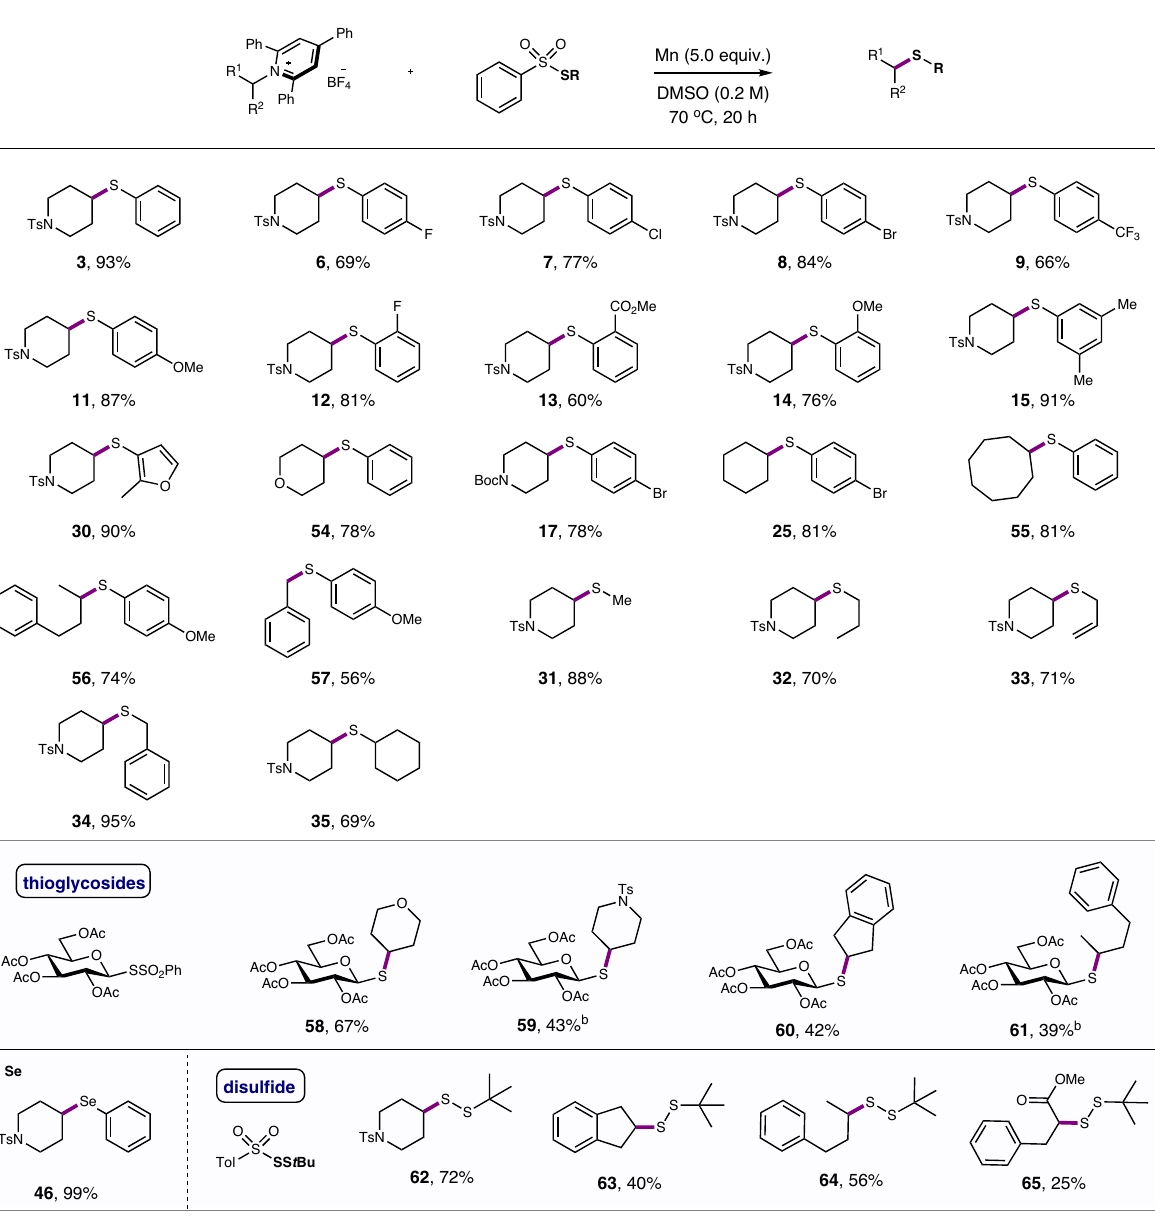
Fig. 4 Model reaction of deaminative thiolation. a Deaminative thiolation. b Control experiment of deaminative thiolation.